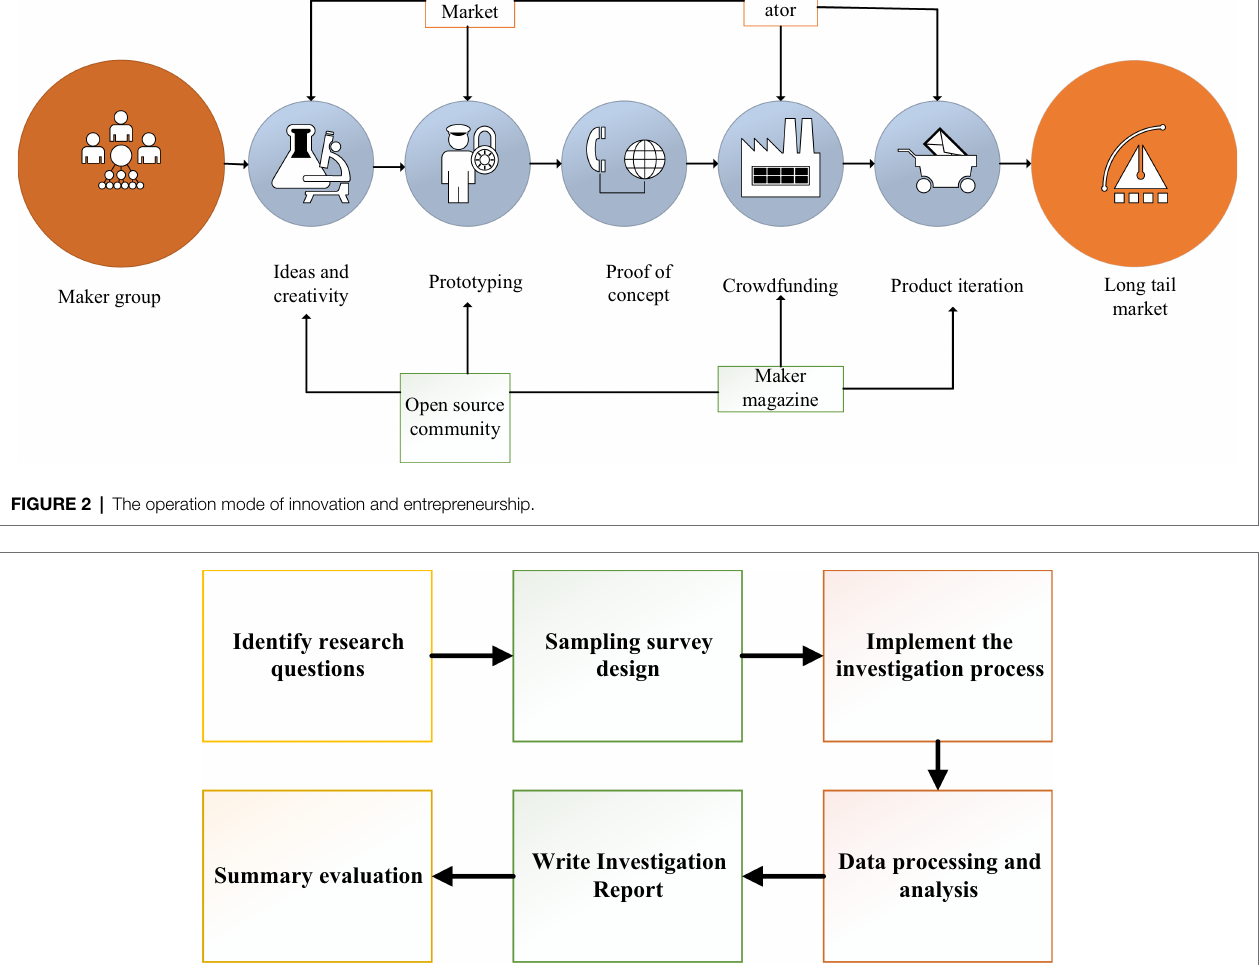
FIGURE 3 | Questionnaire survey